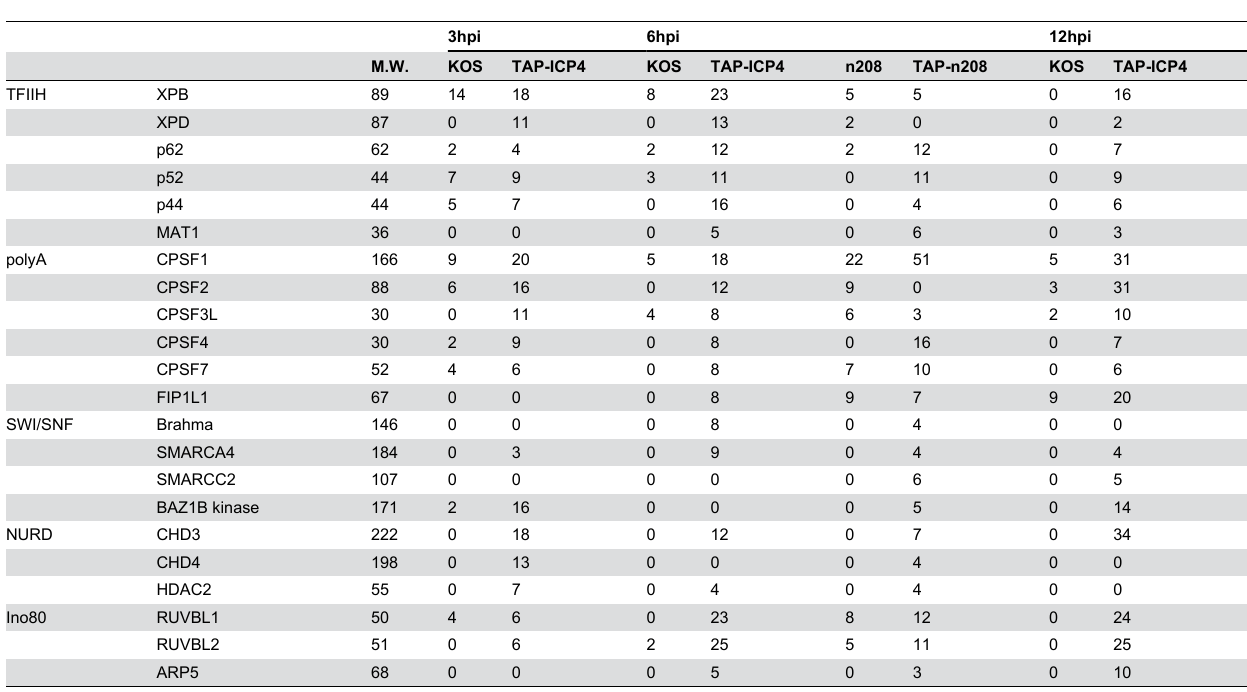
Table 2. Novel complexes copurifying with ICP4 (spectral